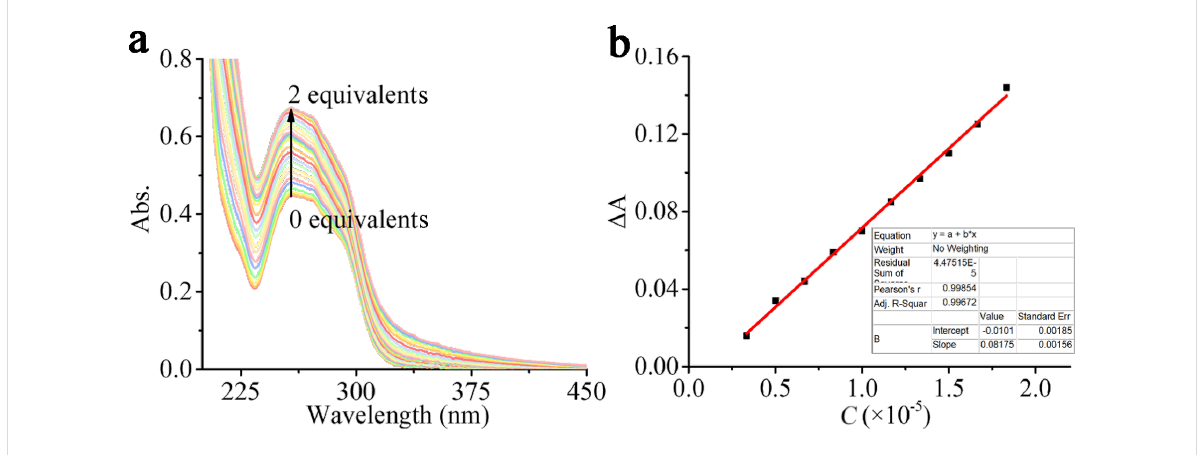
Figure 6: The UV–vis spectra (a) of Q[7]-TBT (20 μ M) with an increasing amount of Ag + from 0.0 to 2.0 equiv; DL plot (b) of Ag + .